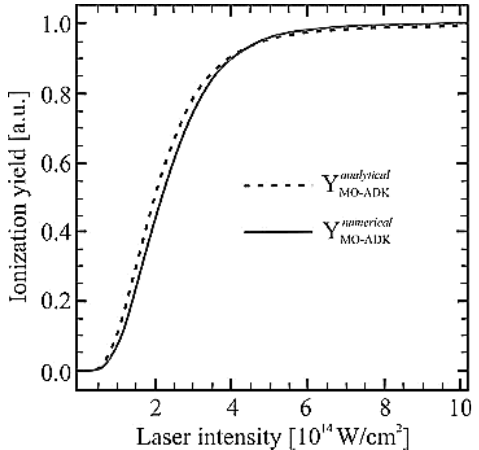
Figure 3. Numerically (solid line) and analytically (dashed line) (Eq. (15)) calculated ionization yields ( 𝜆 = 800 nm ) for the ammonia molecule using the MO-ADK